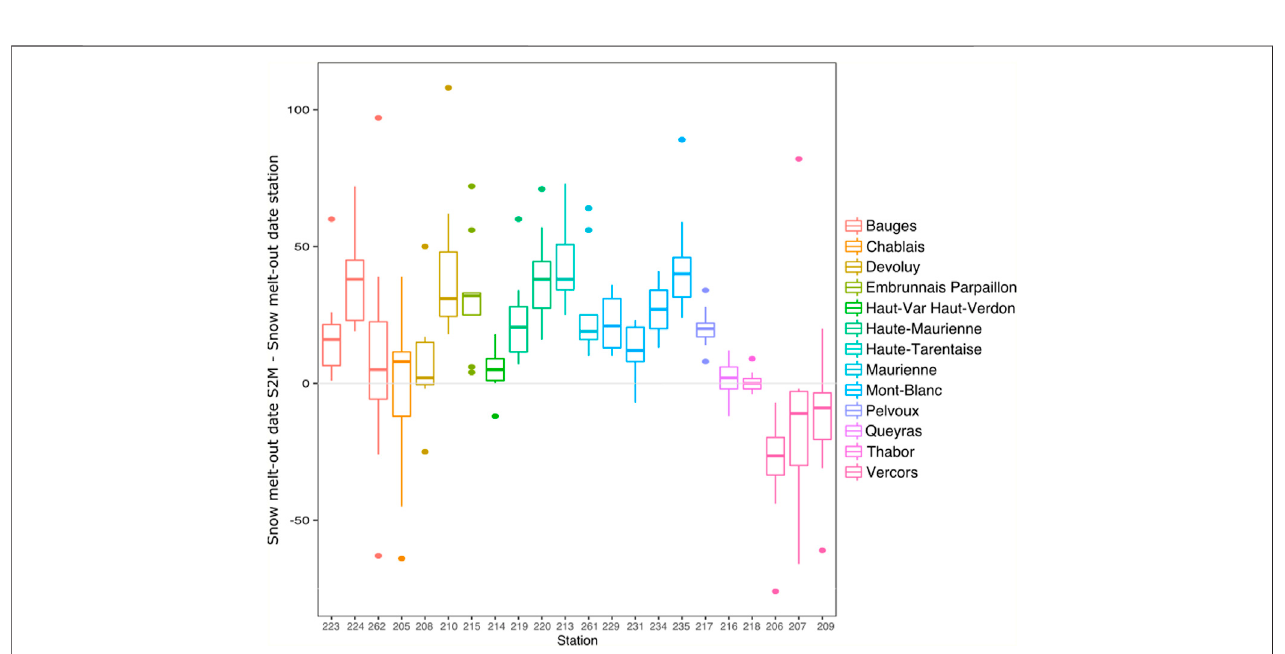
FIGURE 7 | Boxplot of differences in snow melt-out date between S2M and stations for each station having at least 5 years with accurate data, divided by massif and by increasing order of elevation.